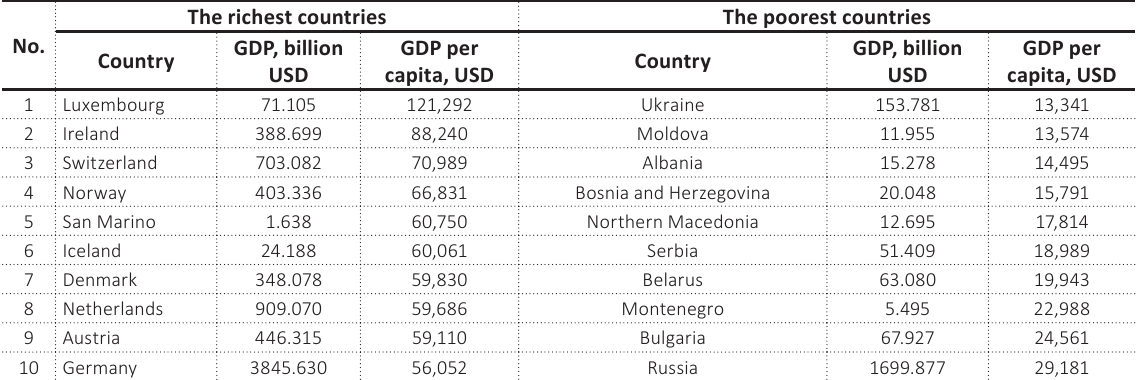
Source: European Central Bank (2021).